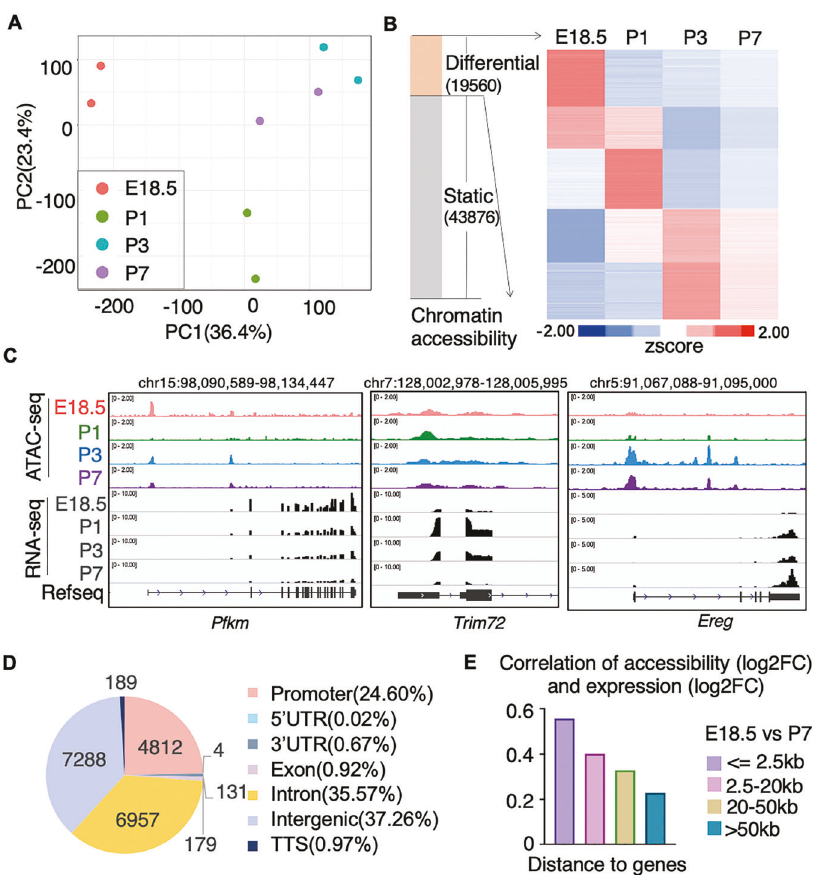
Fig. 2 Dynamic changes of regulatory elements in perinatal cardiomyocytes. A Principal components analysis (PCA) of chromatin accessibility pro fi les. B Bar-chart shows the fraction of static or differential chromatin accessible regions during the perinatal window (left). Heatmap shows the dynamic chromatin accessibility of those differentially accessible regions (right). The groups of regions with decreasing or increasing accessibility after birth are marked. C Genome browser view of Pfkm, Trim72 and Ereg loci with gene expression and chromatin accessibility in cardiomyocytes. D Genomic distribution of differential chromatin accessible regions in cardiomyocytes. E Pearson correlation between log2 fold-change (log2FC) of chromatin accessibility of these differentially accessible regions and log2FC of gene expression of their nearest differential genes in E18.5 vs.